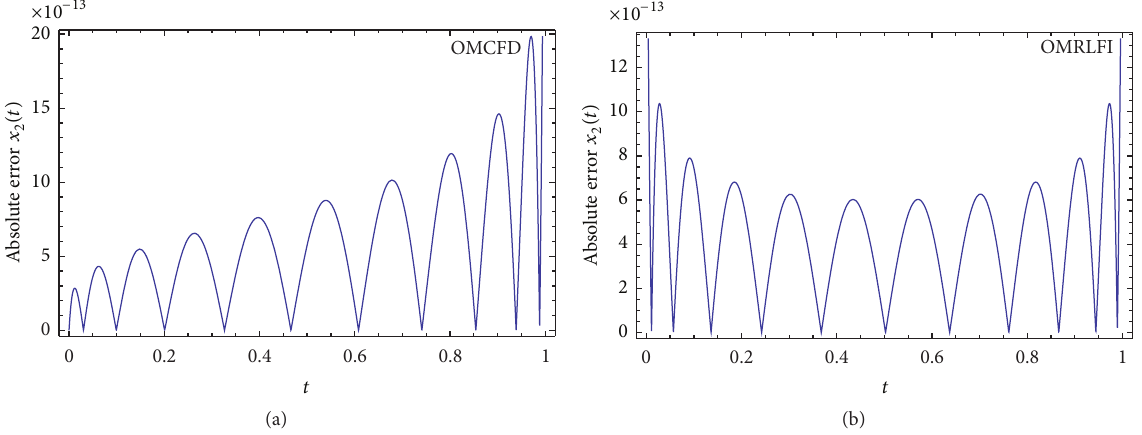
Figure 4: Plot of absolute error function 𝑥 2 (𝑡) for 𝛼 1 = 𝛼 2 = 1 and 𝑚 = 10 by OMCFD and OMRLFI in Example